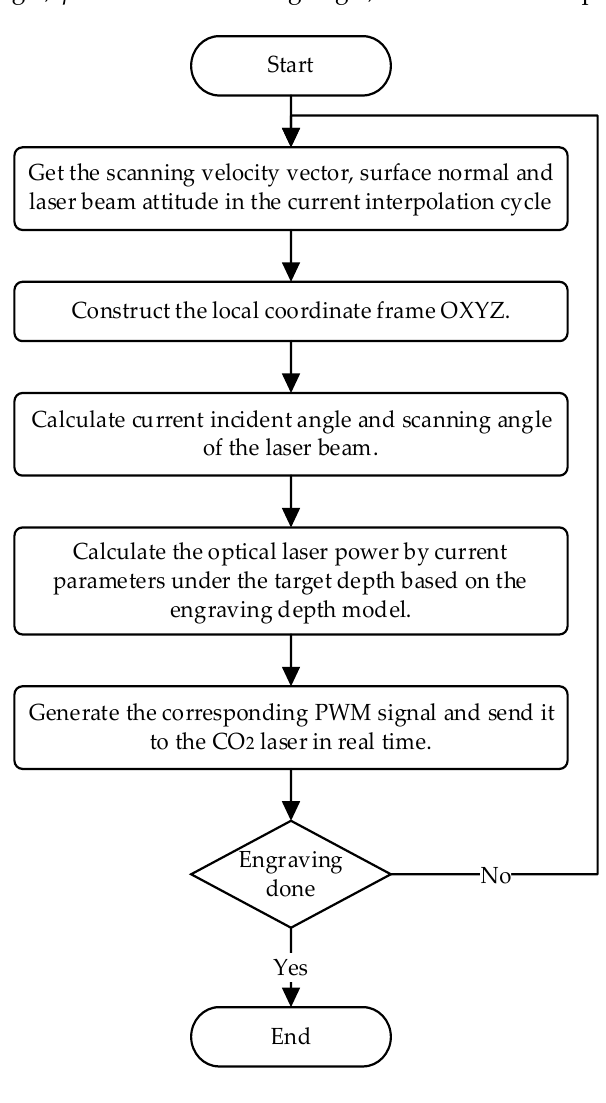
where x is the X position of the trajectory curve, y is the Y position, θ is the laser incident angle, ϕ is the laser scanning angle, and u is the curve parameter.